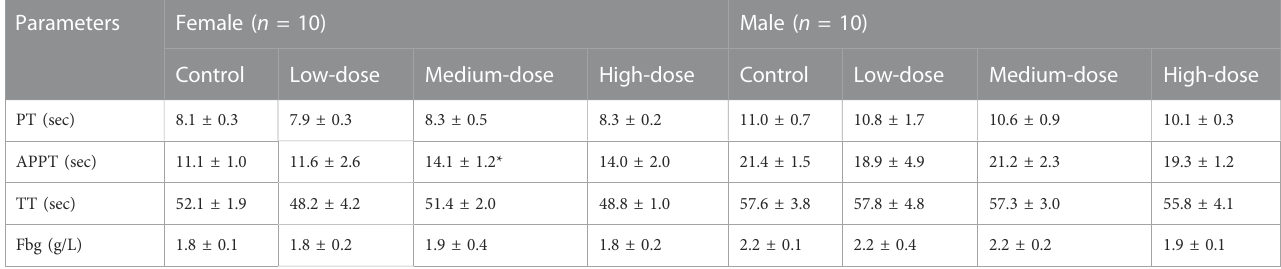
*Indicates p ≤ 0.05 as compared to control